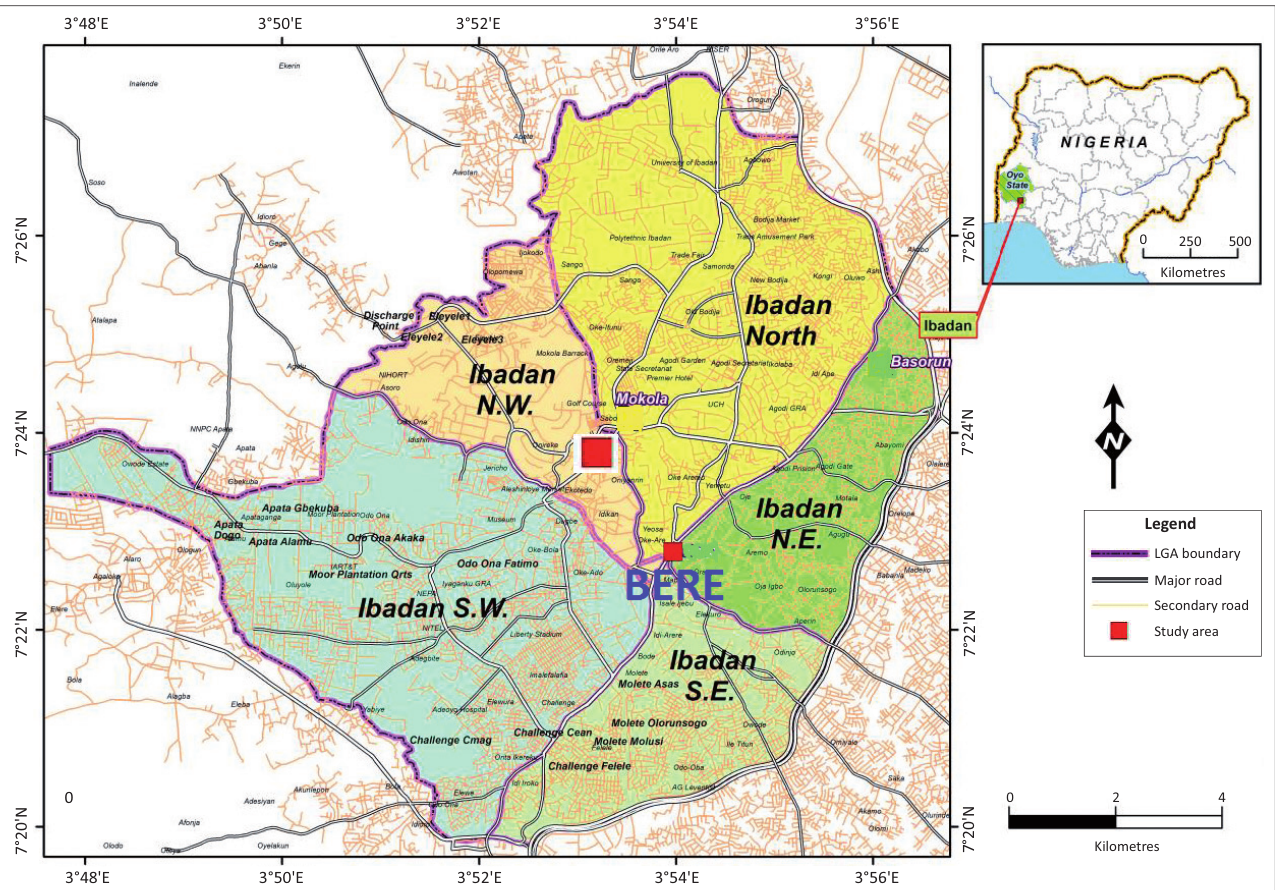
FIGURE 1: Map of Ibadan metropolis showing Bere location in the core area of the city